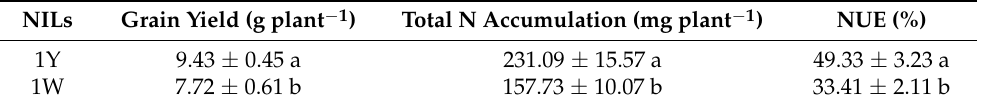
Table 1. Yield, total N accumulation, NUE of the two wheat NILs at the maturation stage. NILs Grain Yield (g plant − 1 ) Total N Accumulation (mg plant − 1 ) NUE (%) 1Y 9.43 ± 0.45 a 231.09 ± 15.57 a 49.33 ± 3.23 a 1W 7.72 ± 0.61 b 157.73 ± 10.07 b 33.41 ± 2.11